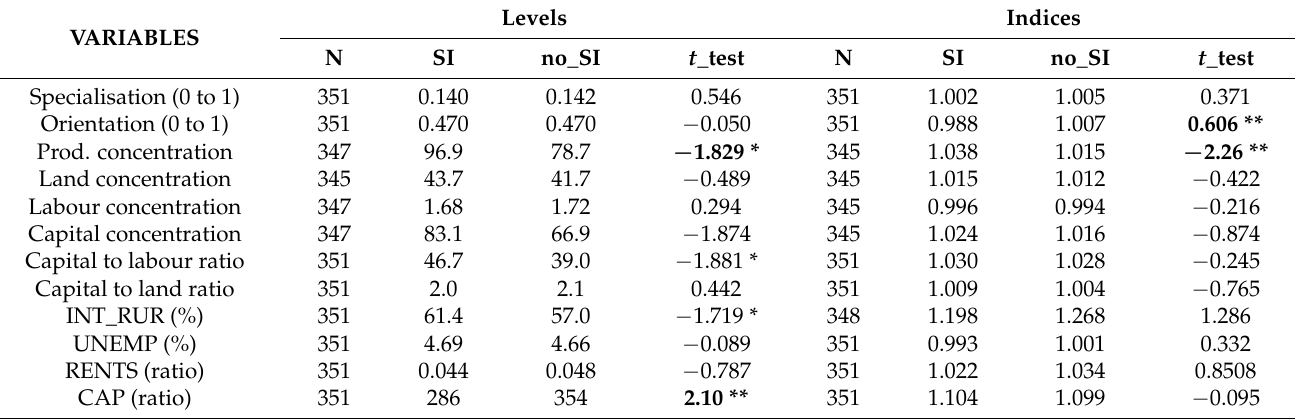
Table A2. T-test values for average levels and indices of determinants of SI